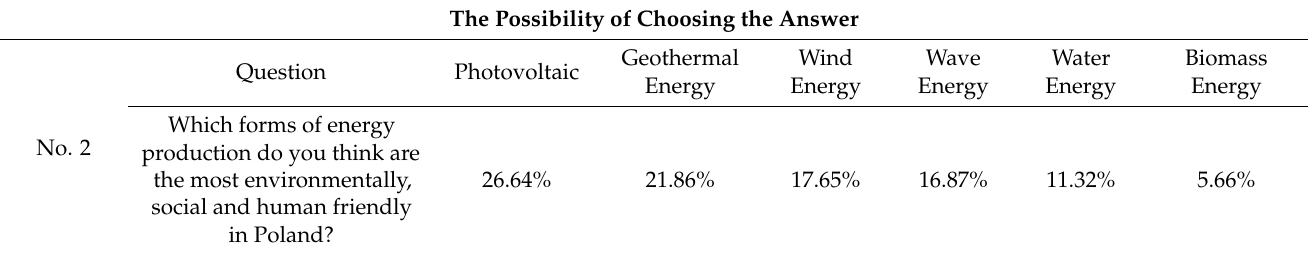
Table 2. Question no. 2, research